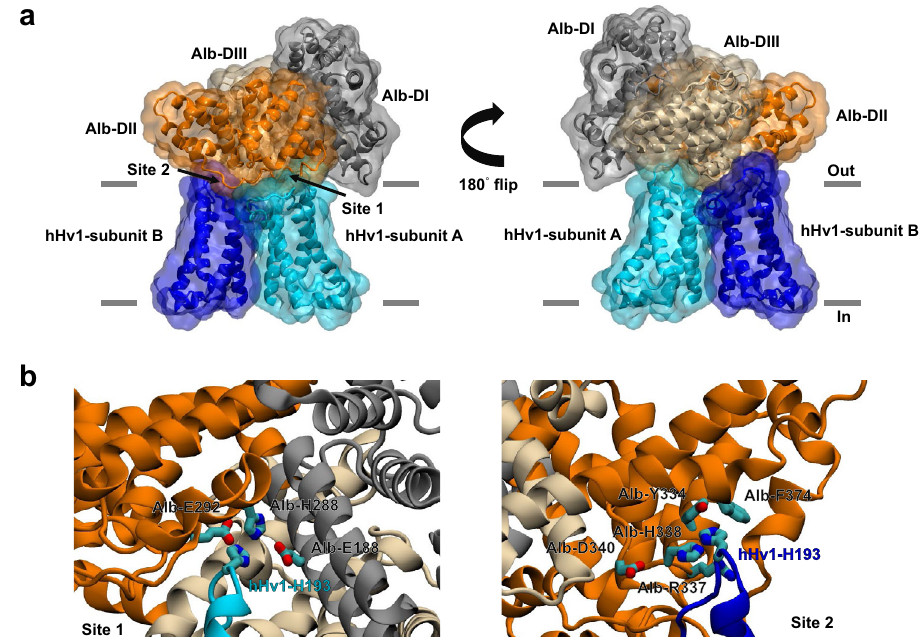
Fig. 6 A proposed Alb-hHv1 structural model from molecular dynamics simulations. a The Alb-hHv1 complex in two orientations showing the three Alb domains DI (gray), DII (orange) and DIII (wheat) and the two subunits (cyan and blue) of a dimeric hHv1 channel. The horizontal gray lines indicate the position of the membrane boundary. b Close-up view of the interaction interface between Alb and two individual hHv1 subunits in two binding sites in the structural model. Left, interaction Site 1, H193 of hHv1 subunit A (cyan) may form direct interaction with Alb residue H288 and the adjacent E188 and E192. Right, interaction Site 2, H193 of hHv1 subunit B (blue) may form direct interaction with Alb residue H338 and the adjacent Y334, R337, and